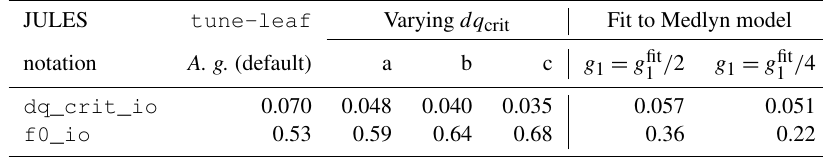
Table A3. Parameter combinations used for the f 0 , dq crit sensitivity studies.